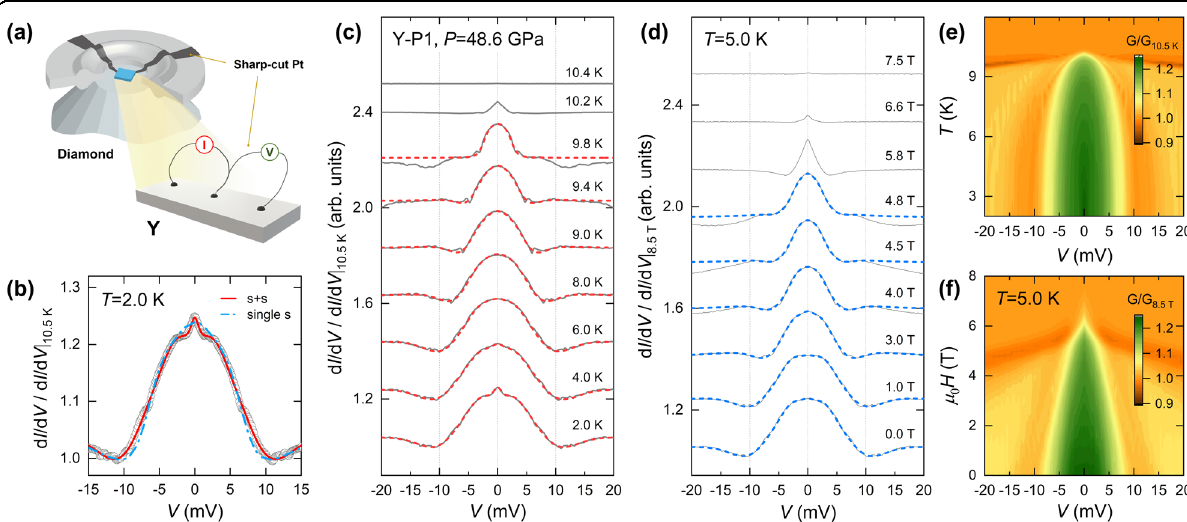
Fig. 3 Quasiparticle scattering spectra at 48.6 GPa. a Schematic diagram of point-contact spectroscopy on Y inside the diamond anvil cell. b Normalized differential conductance, (d I /d V )/(d I /d V ) 10.5 K , at 2.0 K as a function of the bias voltage. The solid and dashed-dotted lines are the best fi ts to the two-band s -wave and single-band s -wave models, respectively. c Temperature evolution of (d I /d V )/(d I /d V ) 10.5 K from 2.0 to 10.4 K. The dotted lines are the best fi ts of data to the modi fi ed BTK model with two gaps plus intergrain Josephson effects (see the main text for details). d Magnetic fi eld evolution of (d I /d V )/(d I /d V ) 8.5 T from 0.0 to 7.5 T at a fi xed temperature of 5.0 K. All the curves are displayed with an offset for clarity. e Contour plot of (d I /d V )/(d I /d V ) 10.5 K of temperature ( T ) vs. bias voltage ( V ), where green (red) represents larger (smaller) differential conductance. f Contour plot of (d I /d V )/(d I /d V ) 8.5 T of fi eld ( μ 0 H ) vs. bias voltage ( V ) at 5.0